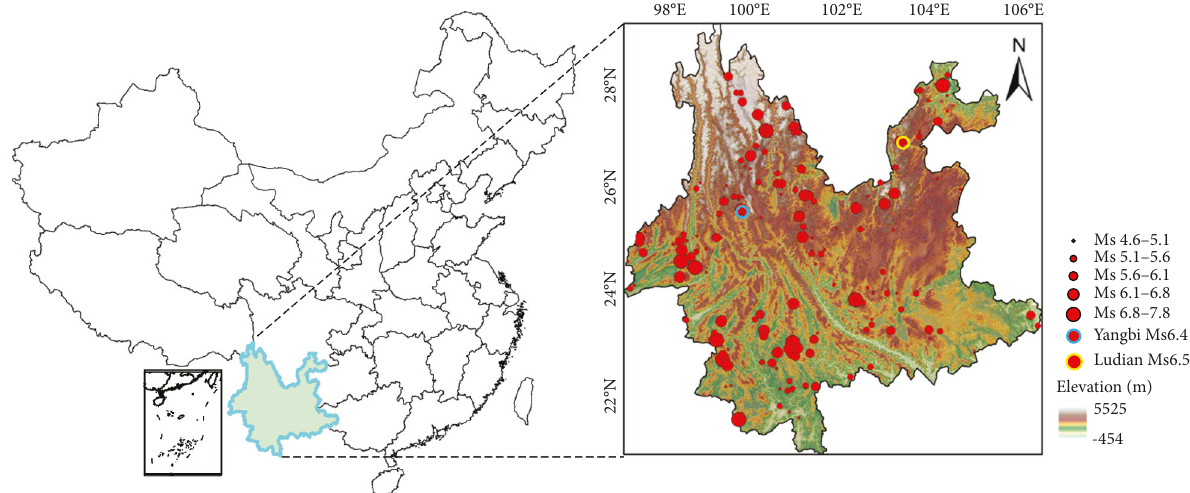
Figure 1: The location of the 2021 Yangbi and 2014 Ludian